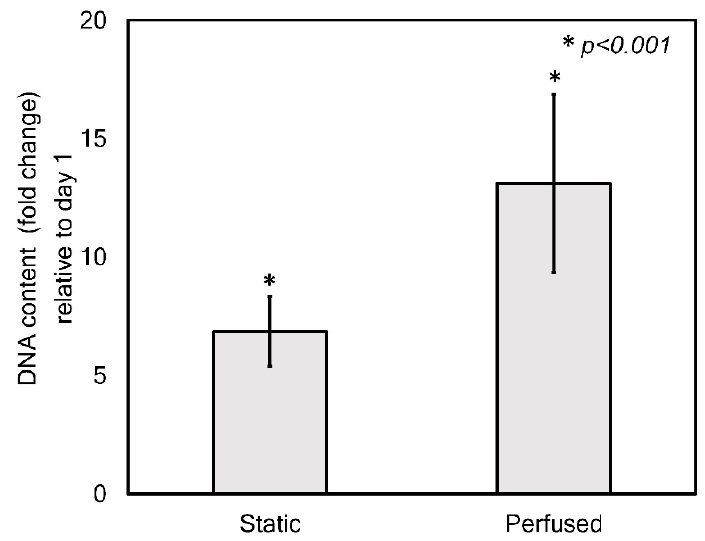
Figure 6. DNA content analysis of the cells cultured under static and perfusion conditions for 1 and 14 days in the chip.